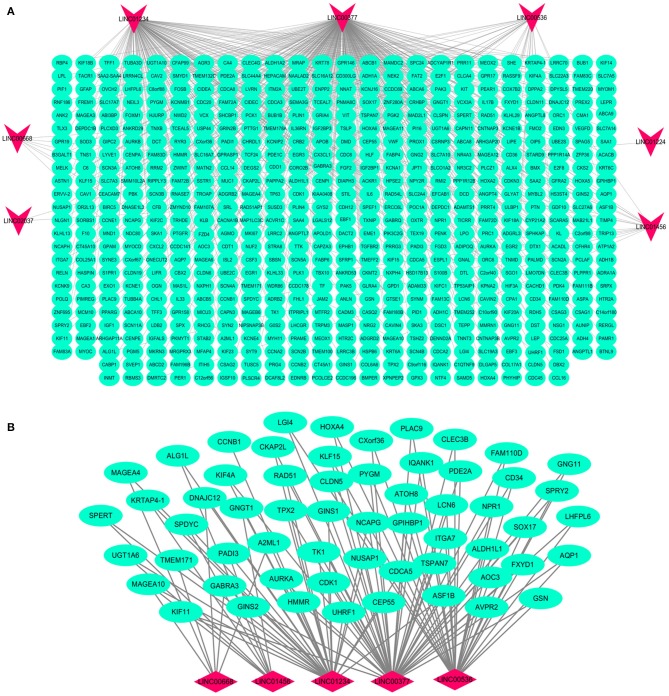
Interaction network map of lncRNAs in the model and related mRNAs. Visualization of the interaction of 7 lncRNAs and 592 mRNAs (A); the mRNAs related to multiple lncRNAs expressions in the model (B). Red nodes representing lncRNA and green nodes representing mRNA.